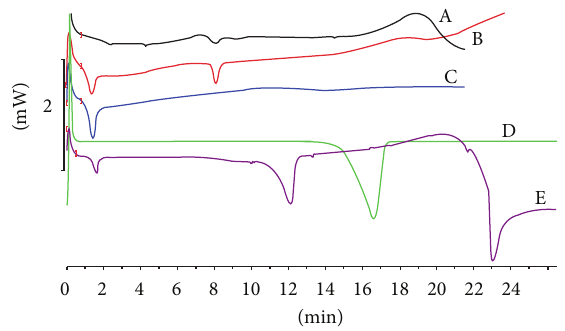
Figure 9: DSC thermogram of A-Cyclosporine, B-Cyclosporine with PLGA, C-PLGA, D-Eudragit RL100, and E-NPs optimized batch F3 (CsA